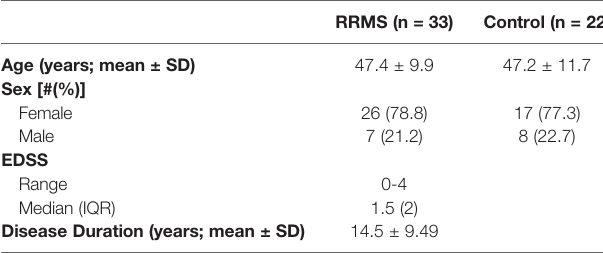
TABLE 1 | Patient Clinical and Demographic